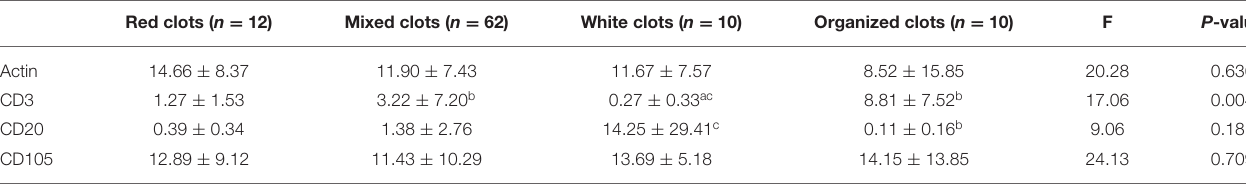
TABLE 2 | Comparison of immunohistochemistry (IHC) staining cells in different clot constitutions. Red clots ( n = 12)